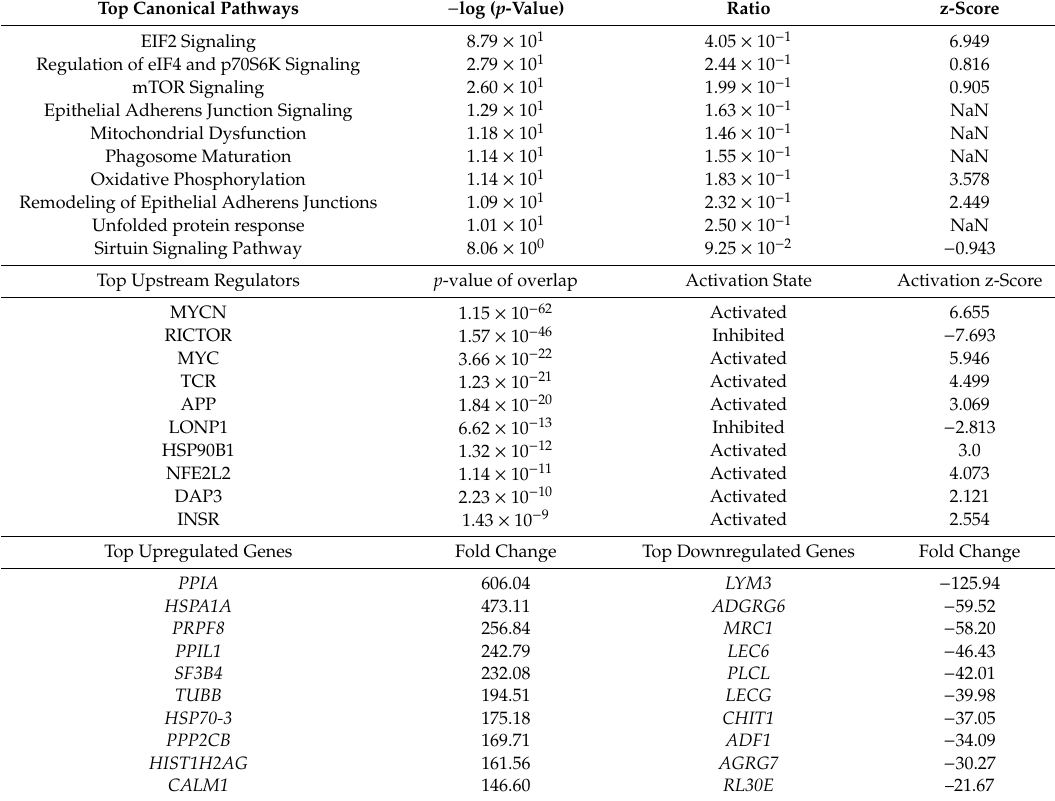
Figure 7 Figure 7. E ff ect of the upstream regulator molecule MYCN on 82 target genes found di ff erentially expressed in the infected zooids. Molecules in red denote upregulation; molecules in green denote downregulation and orange denotes a predicted activation. Coloring of the lines denotes the predicted e ff ects: activation (red), inhibition (blue), and not predicted (grey) on the target molecules or indicates inconsistent findings with the state of the downstream molecules (yellow). Table 2. A brief summary of IPA analysis of DEGs identified in the infected zooids. The p -values were derived by IPA from Fisher’s exact test. Genes are rank ordered by fold change (positive or negative values). NaN, a z-score cannot be calculated for Ingenuity canonical